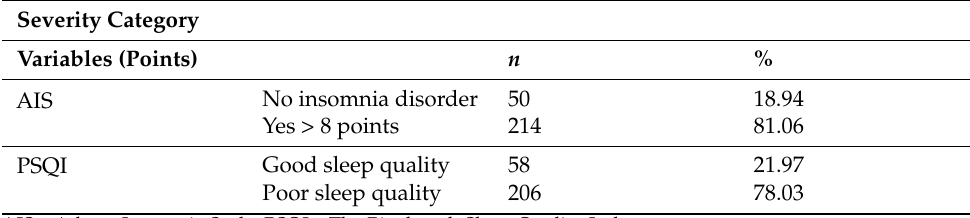
Table 1. Sleep disorder of the respondents.